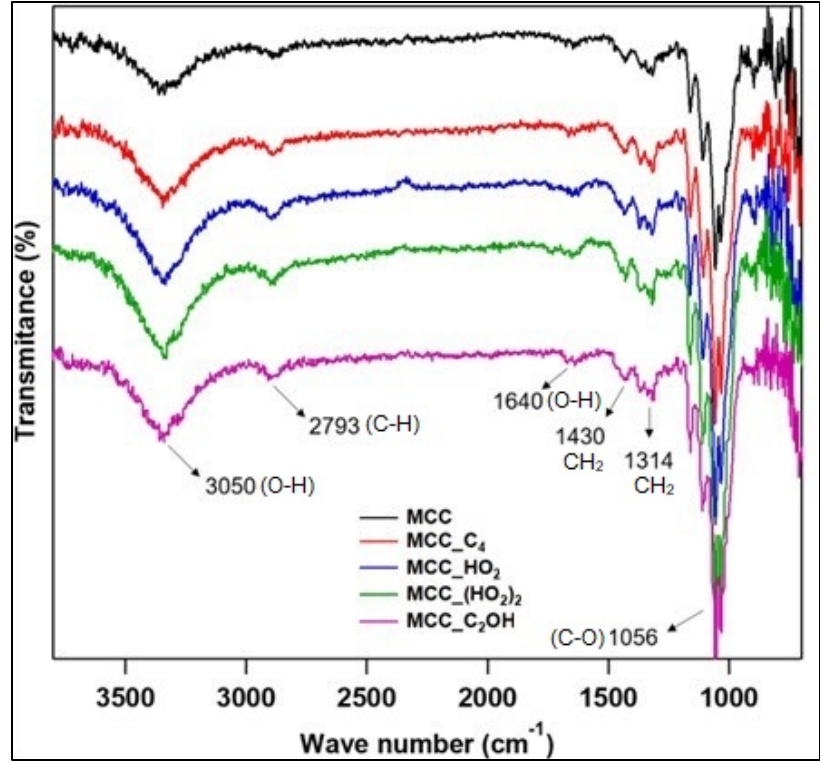
Figure 3. FTIR transmittance spectra of the MCC treated with 1 wt.% of the ILs.